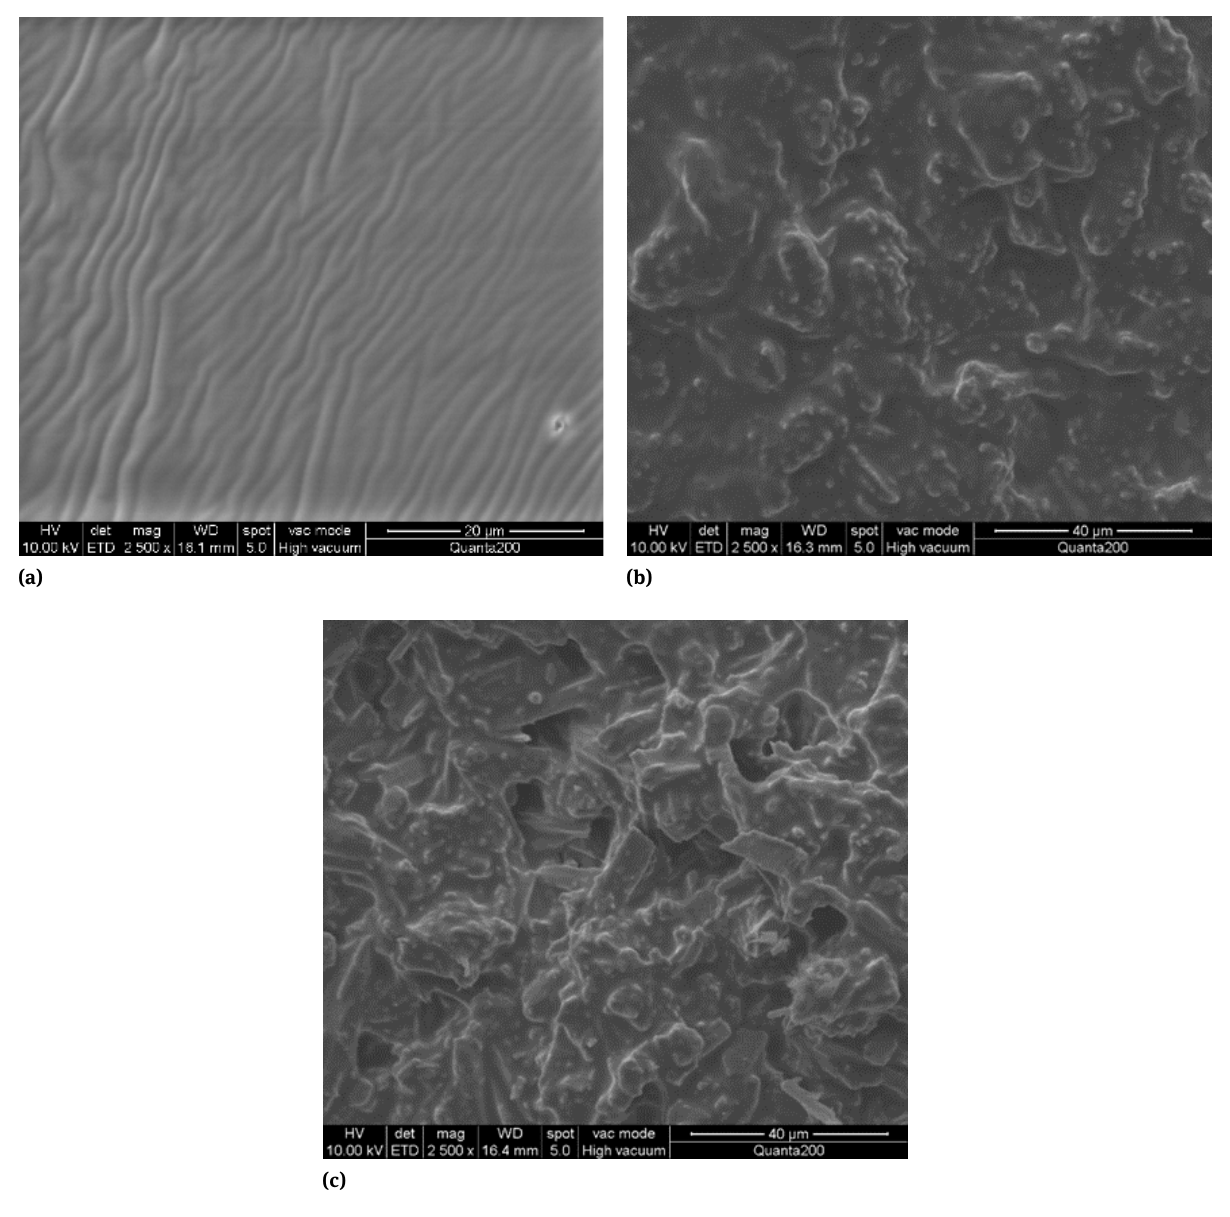
Figure 14: The SEM images of UV curable Hybrid Coatings. a) 0%; b) 6%; c) 12%